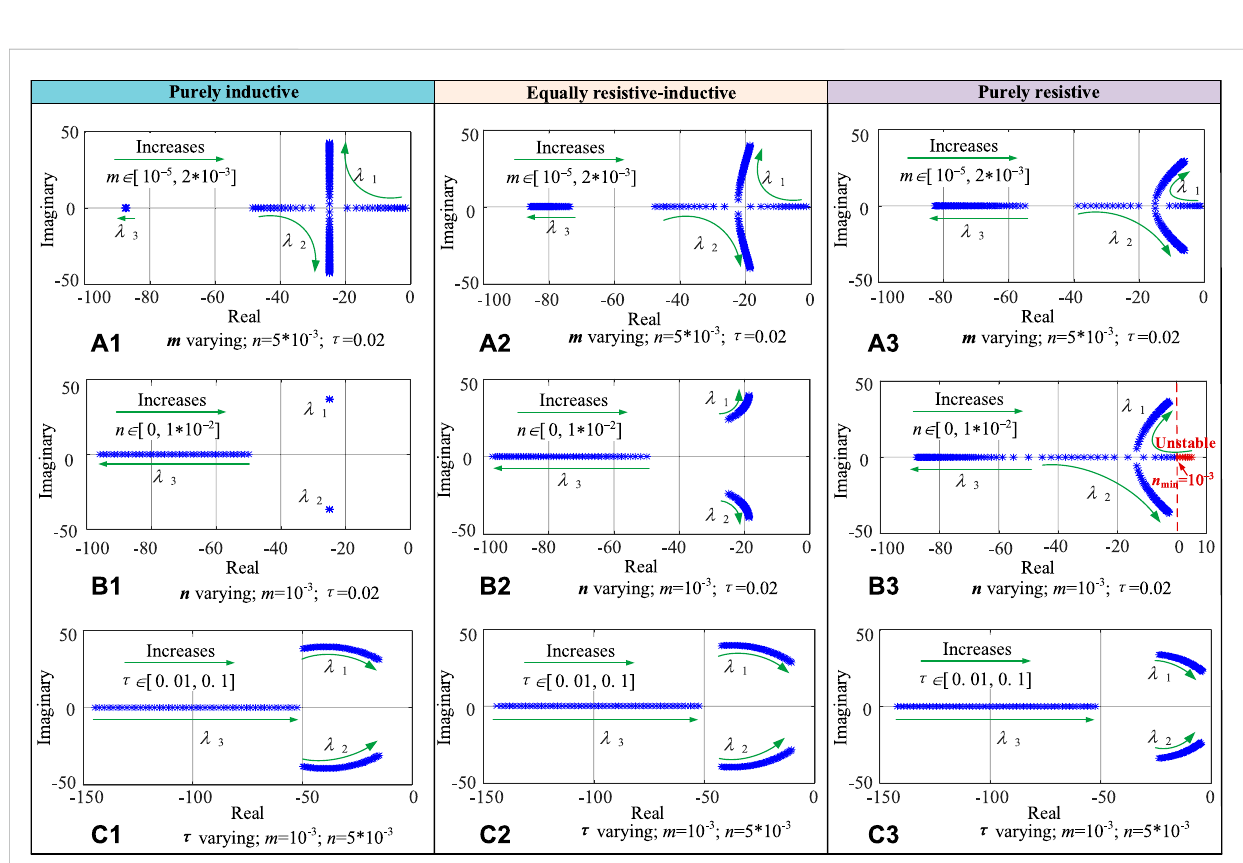
FIGURE 8 Root trajectory analysis under three line impedances (A) m variation; (B) n variation; (C) fi ltering constant τ